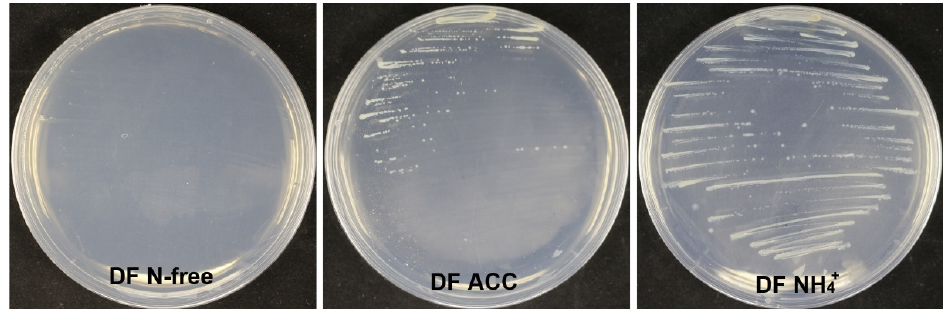
Figure 10. Growing on the DF medium with ACC (DF ACC) as the sole nitrogen source indicates that strain XL17 produces ACC deaminase. Strain XL17 cannot grow on the nitrogen-free DF medium (DF N-free) but grows well on the DF medium with ACC or ammonia (DF NH 4+ ) as the sole nitrogen source.